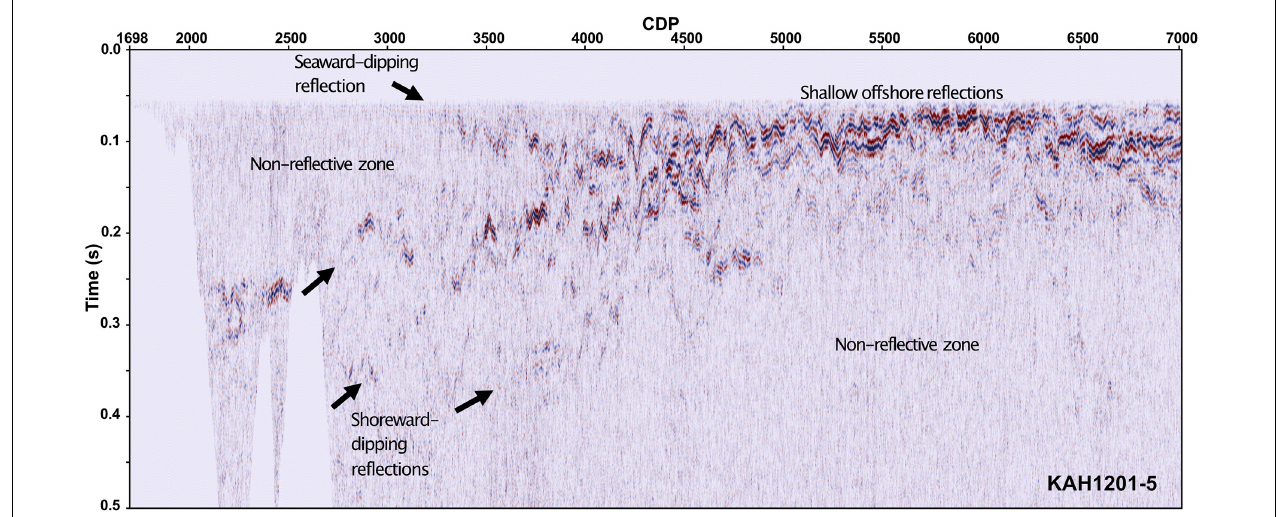
FIGURE 4 | Processed seismic image for line KAH1201-5 from the CB